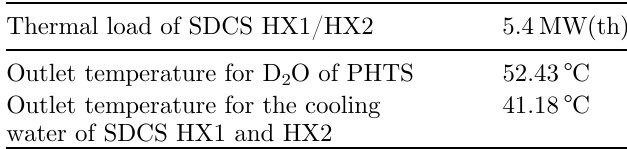
Table 8. Comparative results from the hydraulic